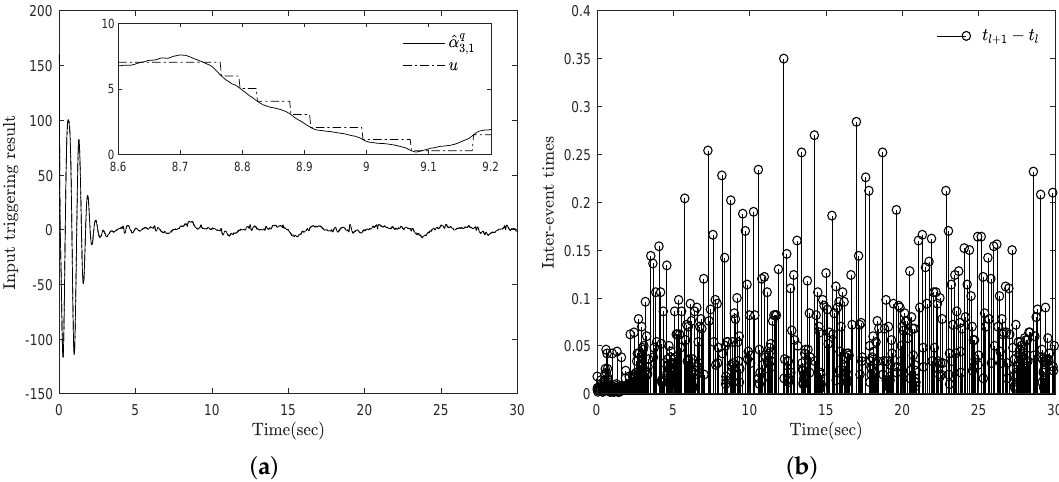
Figure 4. Input triggering result and inter-event times of the proposed approach for Example 1 ( a ) ˆ α q and u ( b ) t l + 1 − t l